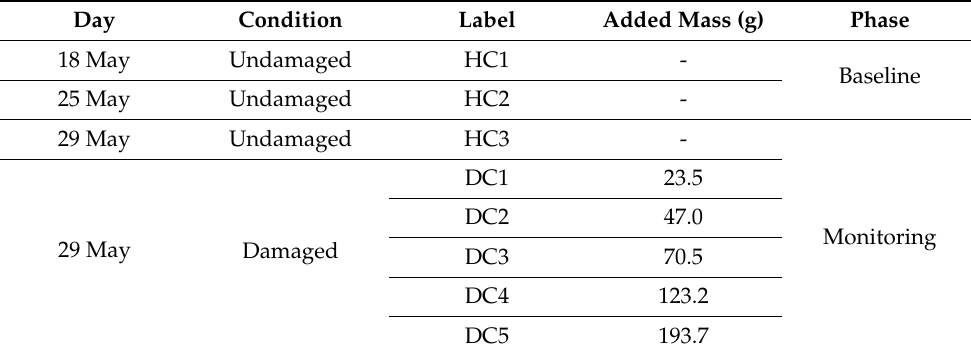
Figure 3. The Wooden Bridge [60]. Table 1. Structural states of the Wooden